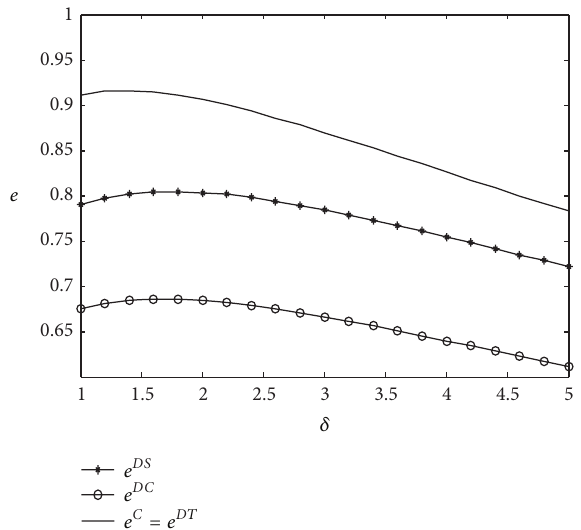
Figure 4: Impact of 𝛿 on optimal emission